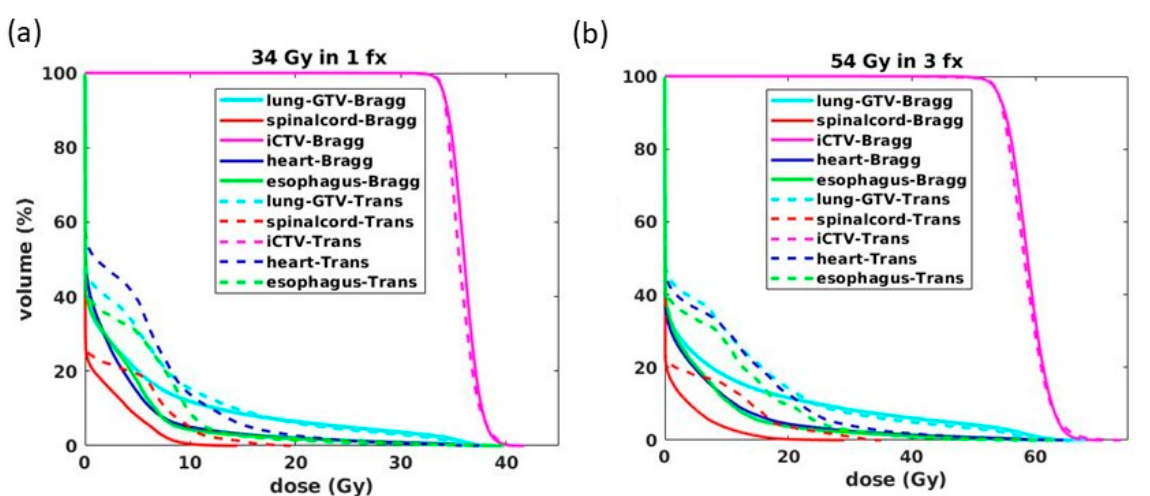
Figure 3. Averaged DVHs of ( a ) 34 Gy/fx and ( b ) 18 Gy/fx Bragg peak (solid lines) and transmission (dashed lines) plans.